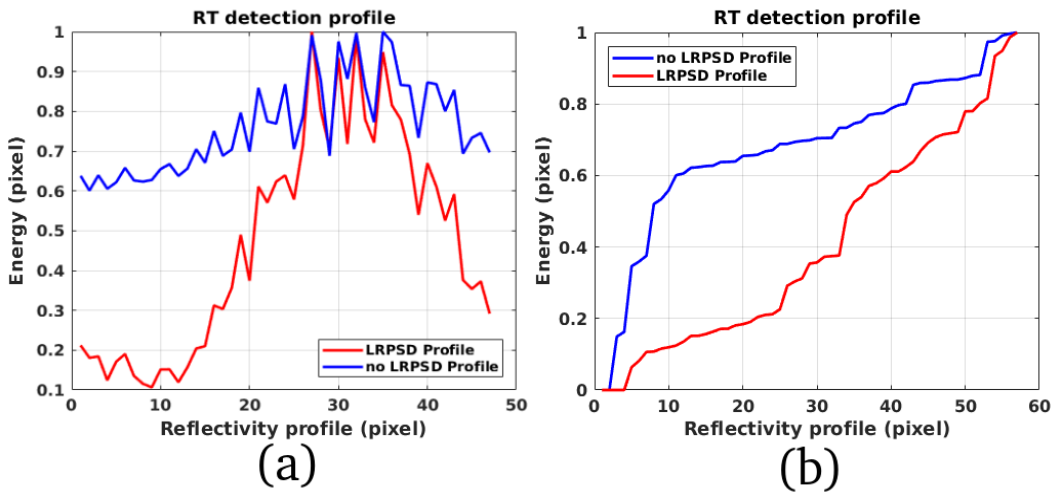
Figure 13. ( a ): Reflectivity profiles. ( b ): Receiving operating characteristic (ROC)